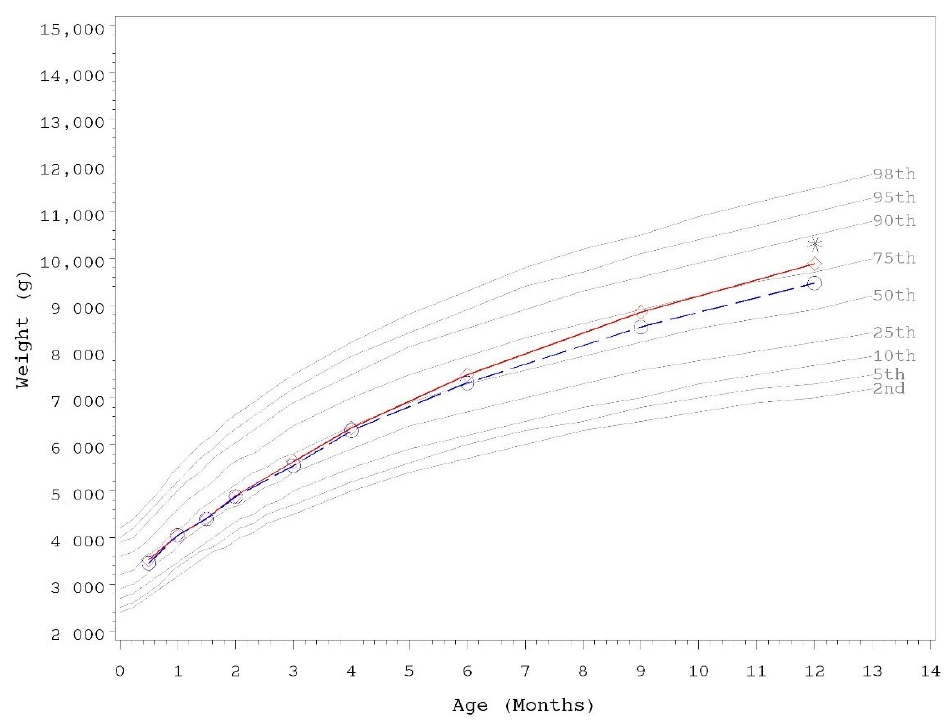
Figure 3. Mean achieved weight for female participants with World Health Organization (WHO) reference percentiles (2nd to 98th) through 12 months (days 14 to 365) of age. Control, red diamonds; INV-MFGM, blue circles. * Denotes significant group difference, p < 0.05, two-tailed ANOVA test.